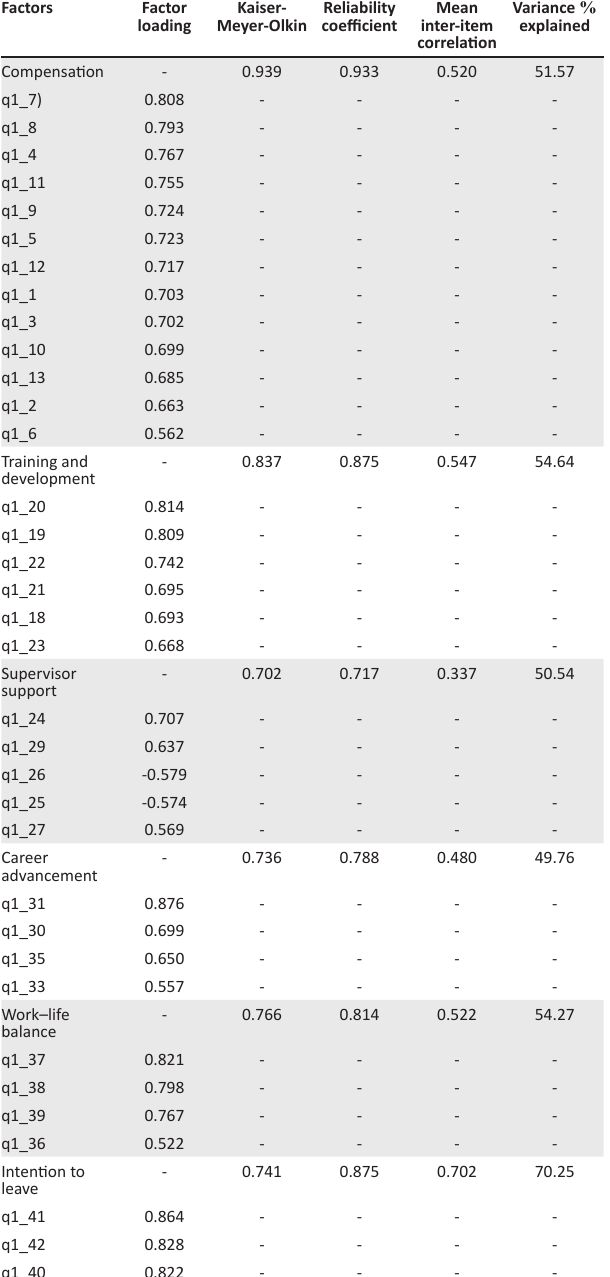
TABLE 4: Factor analysis for Retention Factor Scale. Factors